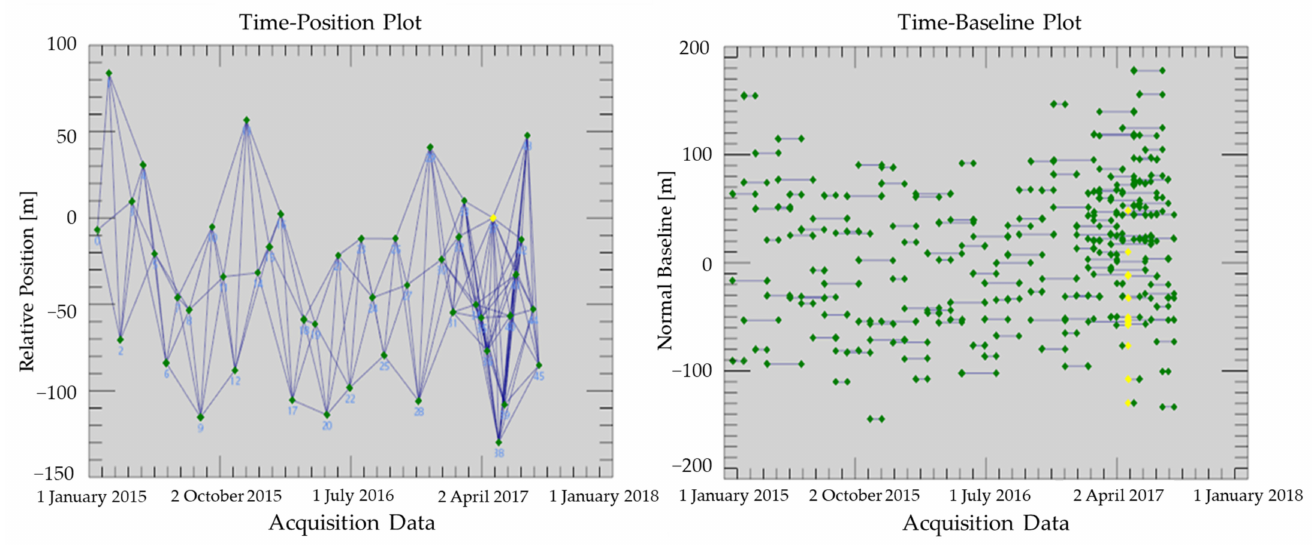
Figure 2. Time-position plot and time-baseline plot of ascending orbit data.